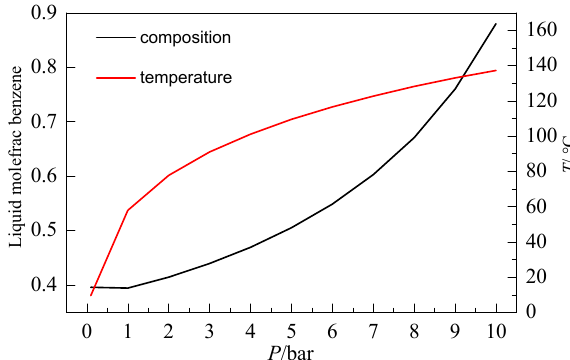
ff ect of pressure on azeotropic composition and Figure 2. Effect of pressure on azeotropic composition and temperature. Figure 2. E